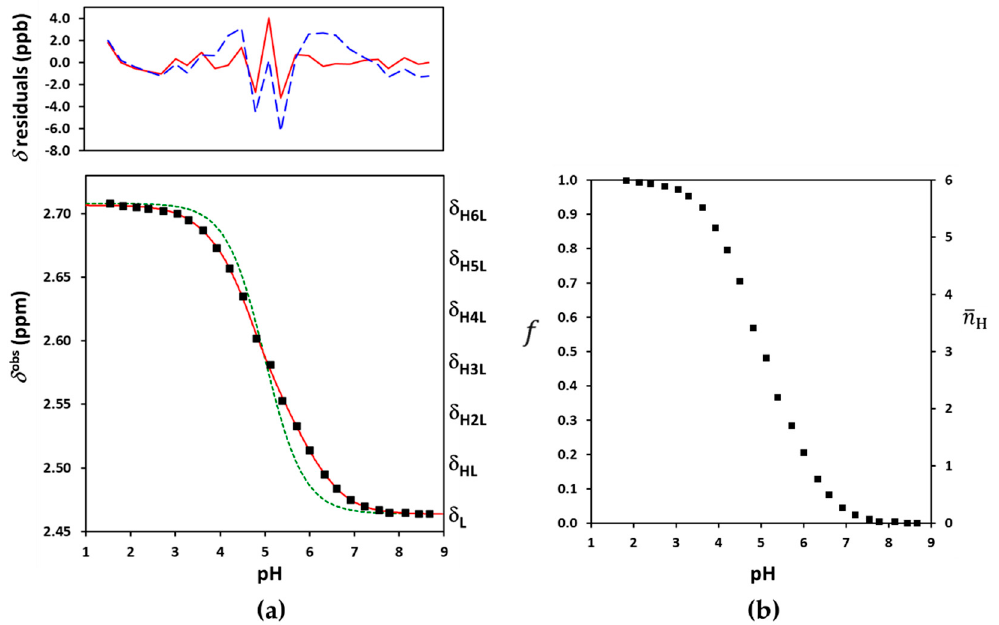
Figure 3. ( a ) The experimental NMR-pH titration curve of Su α -CD 8-CH 2 protons in squares. The green dashed line is generated by fitting the site-binding model without p ε , while the solid red line represents the fits by the ED-macro, Q-fitting or the single-p ε site-binding models. The residuals by the ED-macro or the equivalent Q-fitting models are given in solid red line, while those by the single- p ε microscopic evaluation by dashed blue line above (see detailed description of these calculations in Sections 2.3–2.5); ( b ) protonation degree functions for individual carboxylates ( f ) and the whole Su α -CD molecule ( n H